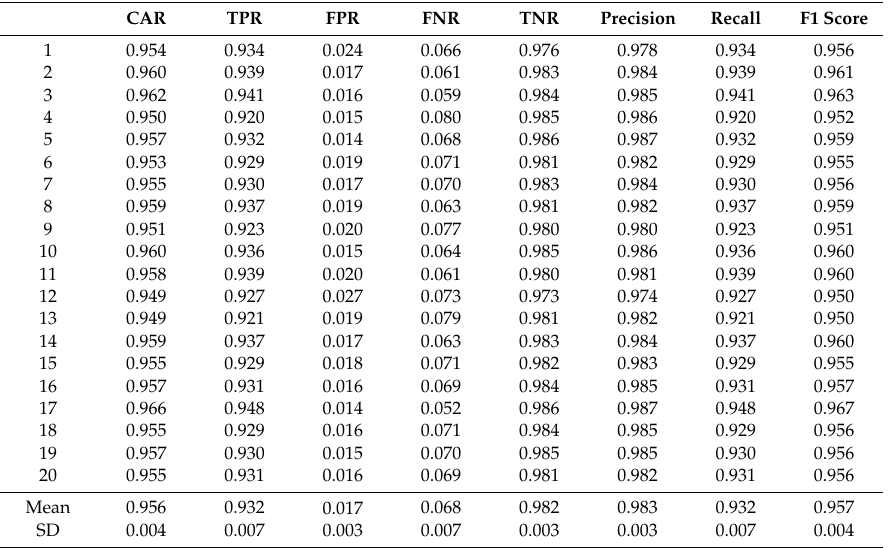
Table 2. Testing performance of the RFM model.